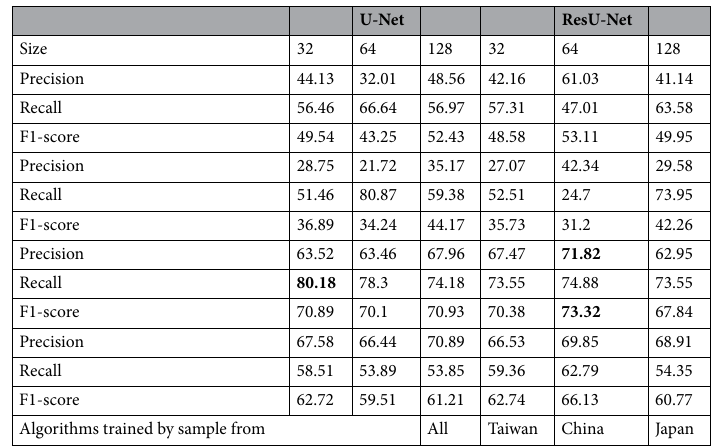
Table 7. The resulting precision, recall, and f1-score values for Scenario 4 (training the algorithms with the training dataset of Japan and testing on the Taiwan, China, Japan, and all test datasets separately). The highest values of precision, recall, and f1-score are indicated in bold.